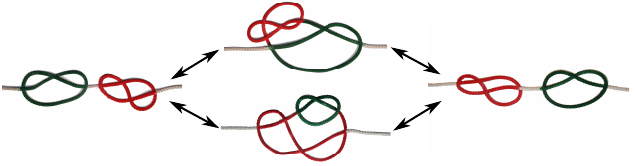
Figure 1. Swapping mechanism. Sketch of a transition event: one of the two knots is embedded in the other knot ( middle ) and diffuses along its contour until the two knots have switched positions ( right ) or returned to their original positions ( left ) along the